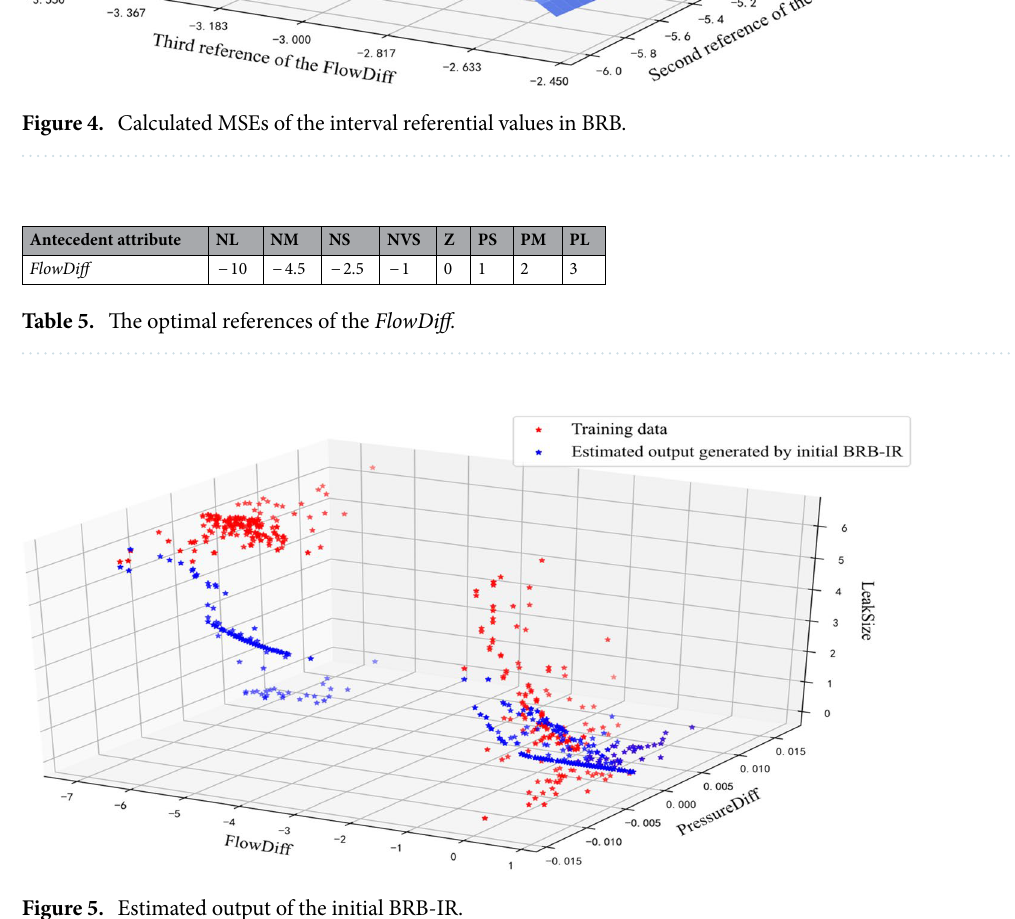
Figure 5. Estimated output of the initial